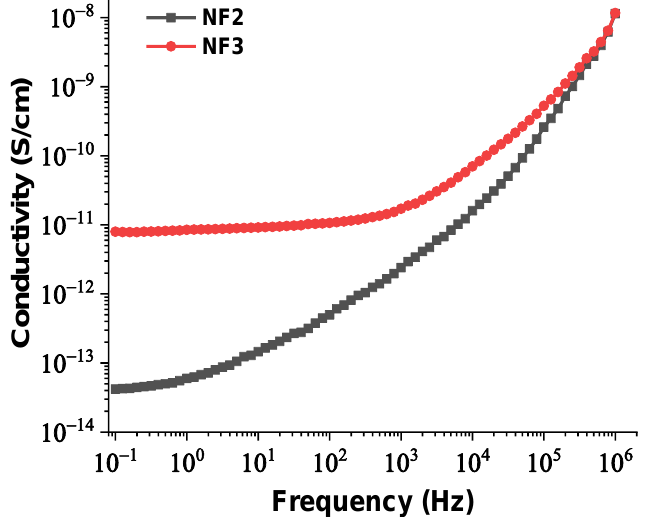
Figure 14. Change in electrical conductivity versus frequency of the NF2 and NF3 samples.